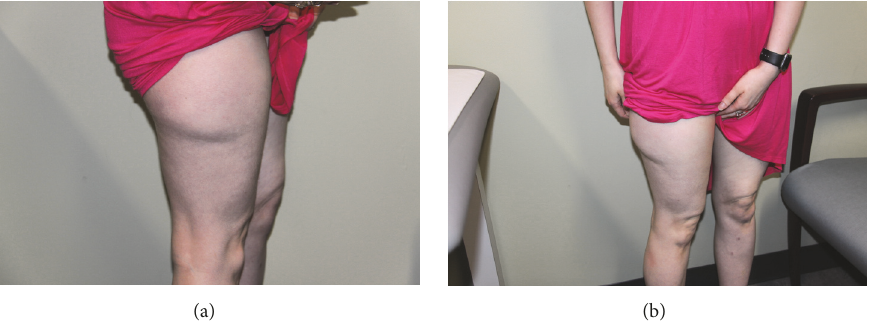
Figure 1: (a) Preop lateral. (b) Preop oblique.